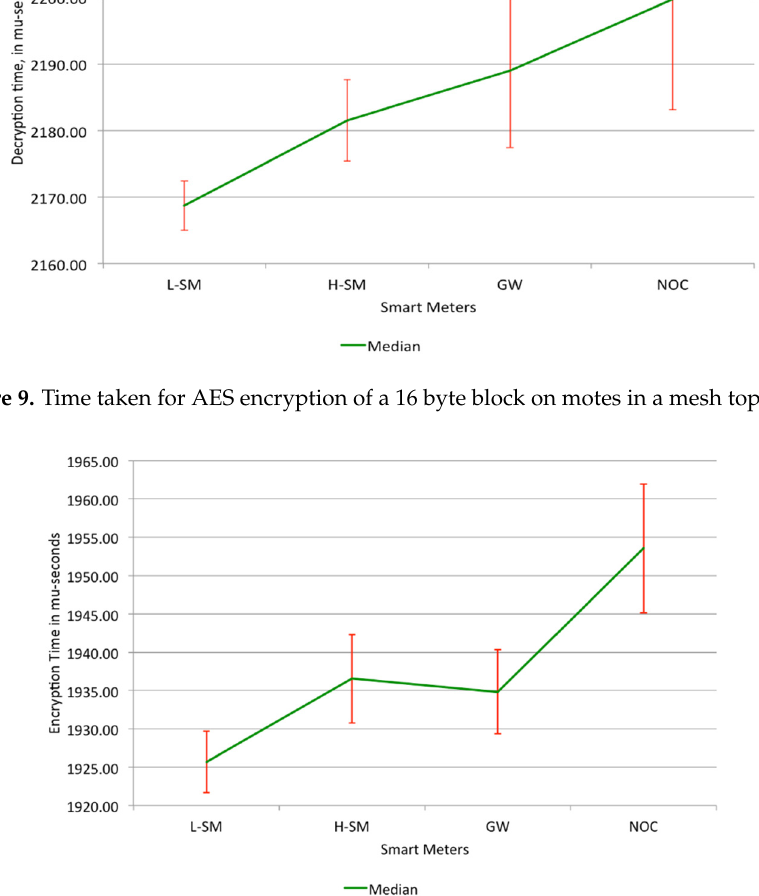
Figure 10. Time taken for AES decryption of a 16 byte block on motes in a mesh topology.